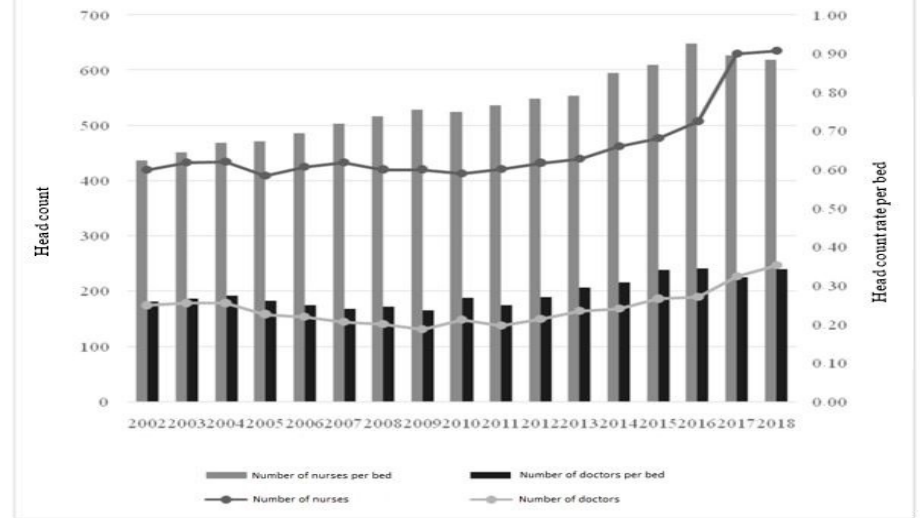
Figure 6. Medical and nursing staff of the analyzed hospital per hospital bed in the analyzed insti-